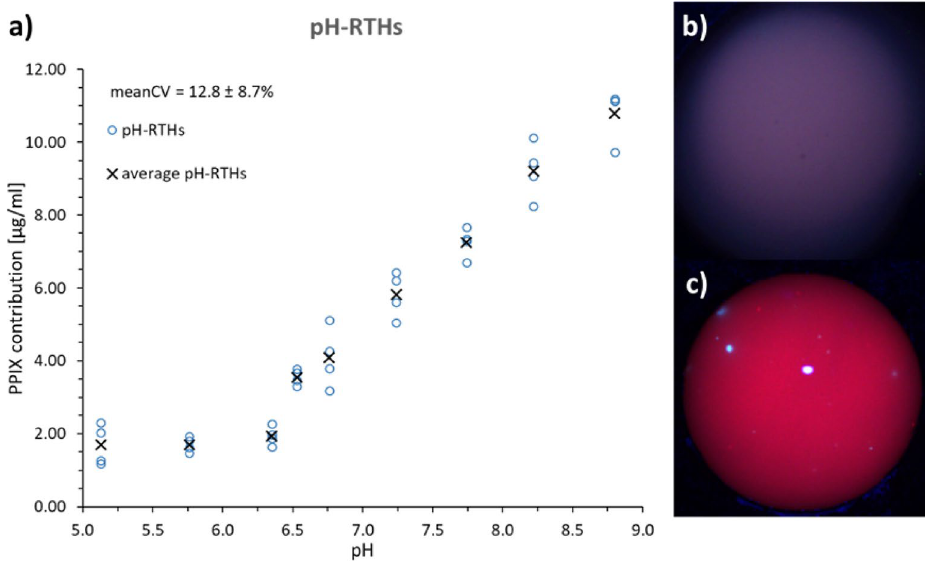
Figure 5. pH-dependence of the measured PPIX contribution as determined with pH-RTHs (PPIX concentration 3.0 pmol/mg). ( a ) PPIX contribution varied strongly with pH (meanCV = mean coefficient of variation ± standard deviation, n = 4). ( b / c ) BLUE 400 images for ( b ) pH 5.1, ( c ) pH